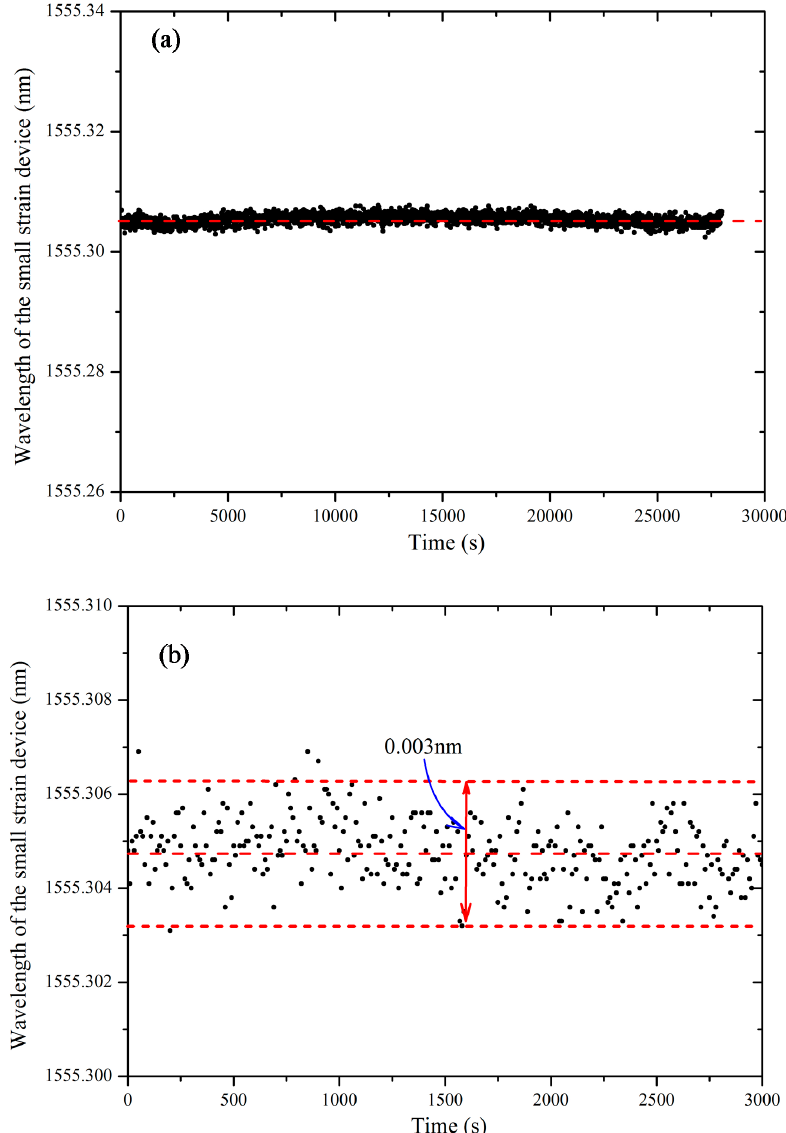
Figure 7. Performance examination of the designed SDT: ( a ) long-term measured wavelengths; ( b ) measured errors of the wavelength.